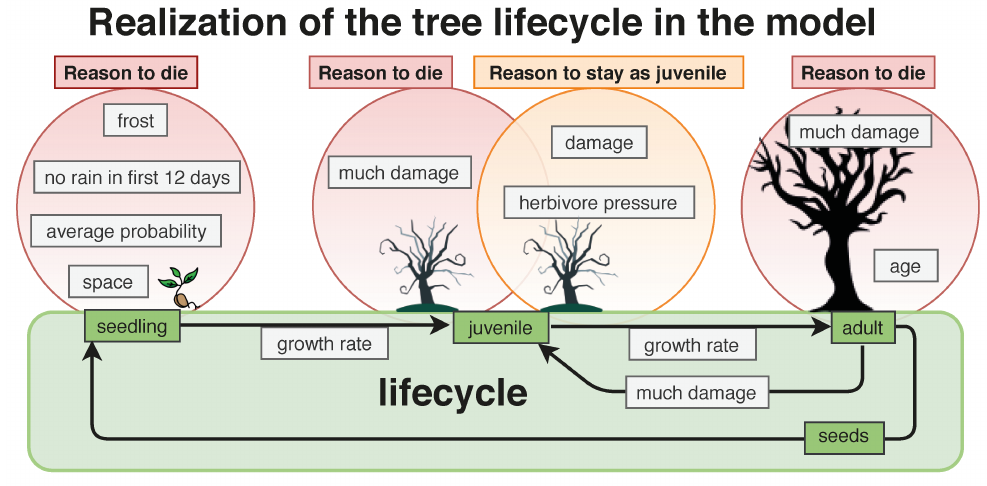
Figure 4. Tree lifecycle: From seed to adult tree or back to